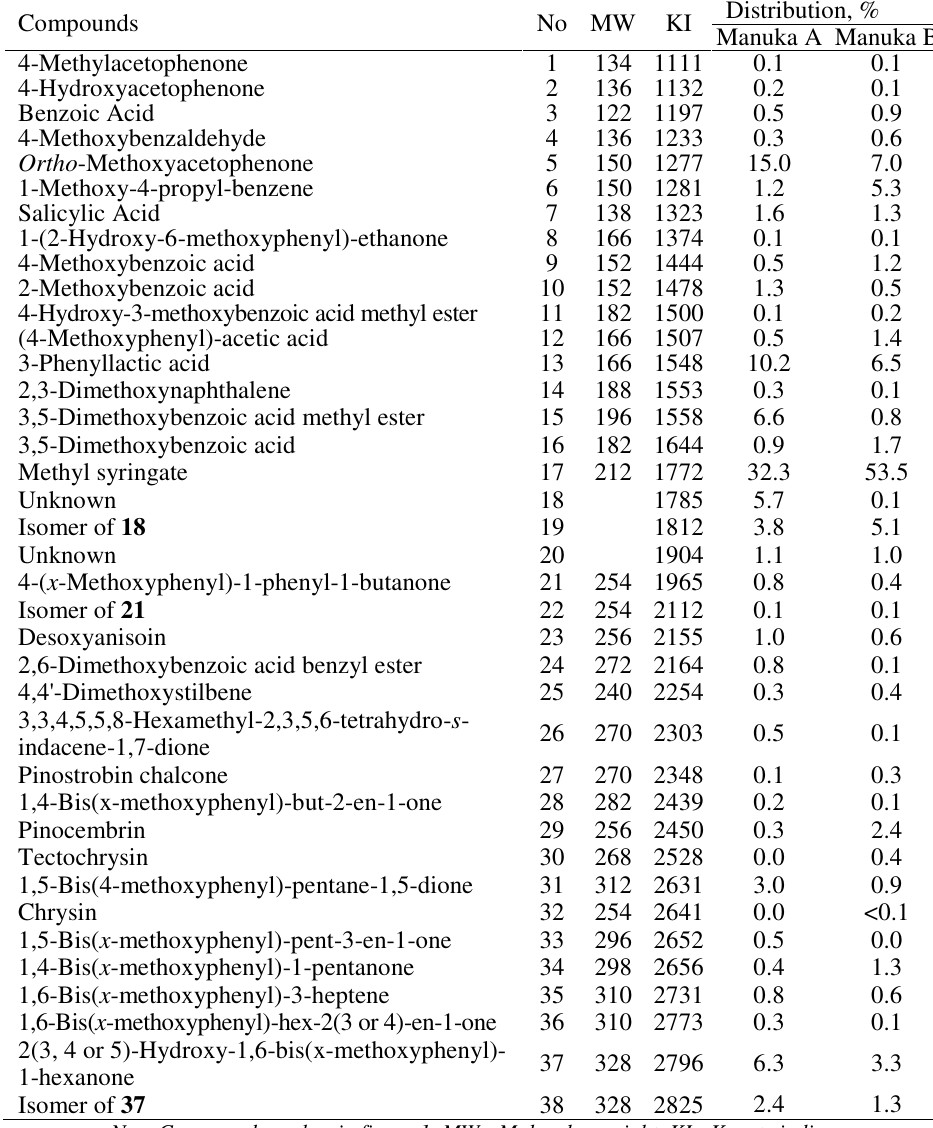
Table 1. Distribution (% of total) of aromatic compounds extracted from two samples of manuka honey using